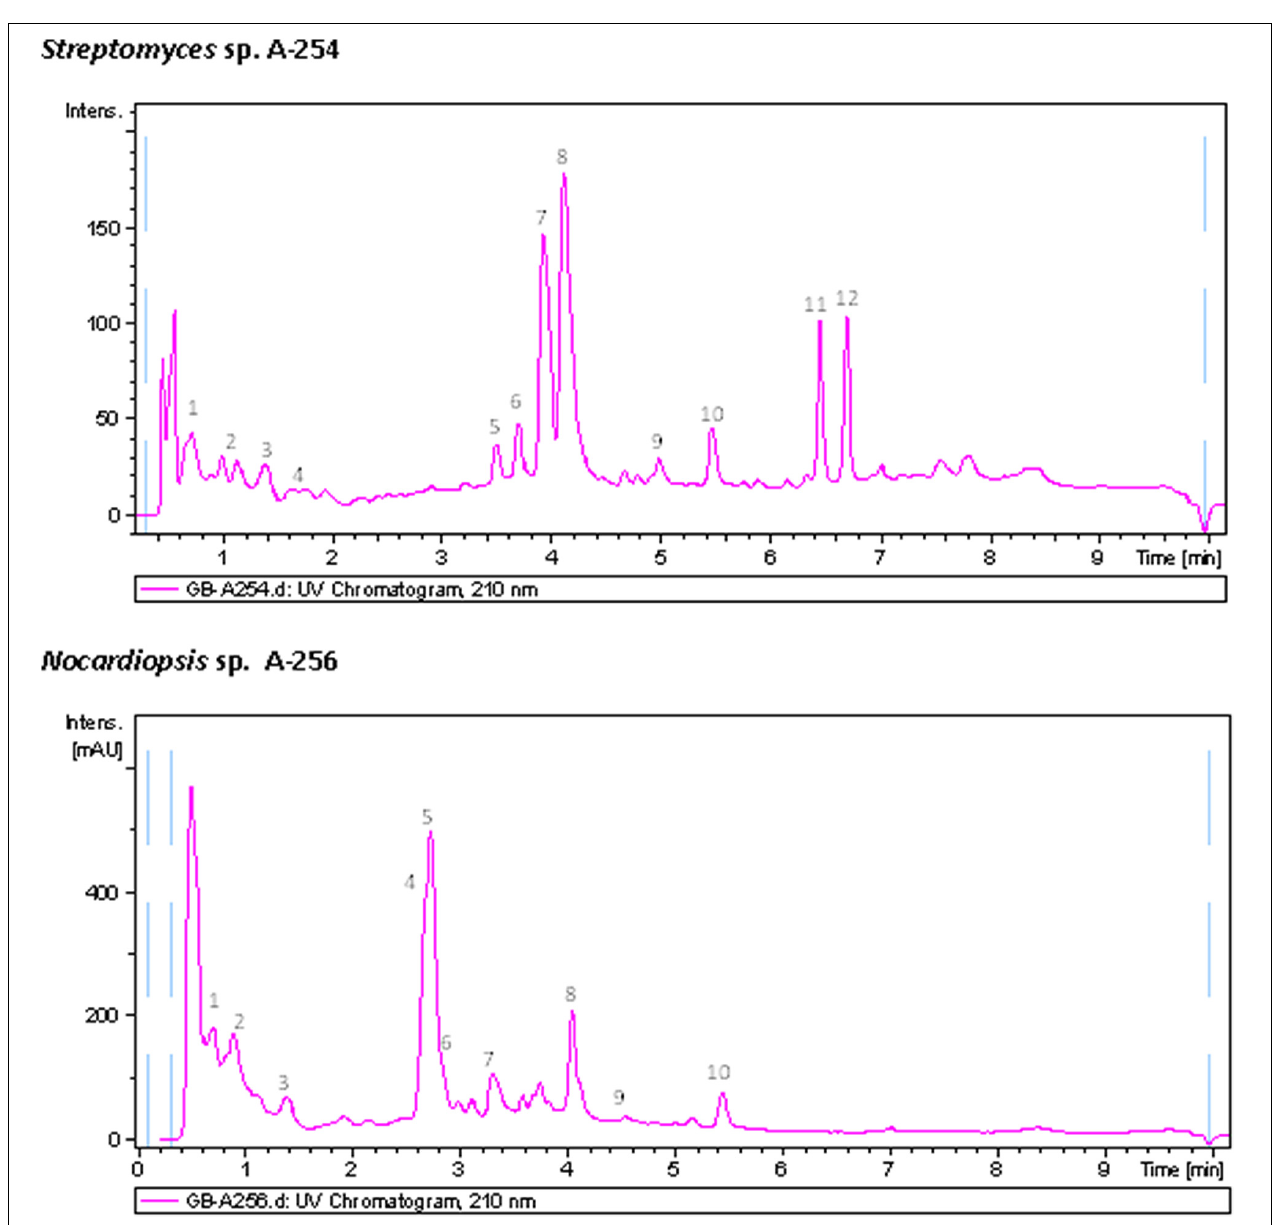
FIGURE 5 | UV 210 nm chromatogram of samples A-254 and A-256 with peaks annotated showing dereplicated components. Dereplicated components in sample A-254: (1) Cyclo(prolylvalyl), (2) Cyclo(leucylprolyl), (3) Cyclo(phenylalanylprolyl), (4) Cyclo(prolytryptophyl), (5) C 21 H 38 NO 9 (related to ravidomycin but with a molecular formula not found in the Dictionary of Natural Products), (6) Deacetylravidomycin, (7) C 30 H 33 NO 9 (related to ravidomycin but with a molecular formula not foundin the Dictionary of Natural Products), (8) Ravidomycin, (9) C 40 H 57 NO 10 (molecular formula not found in the Dictionary of Natural Products), (10) Tetronomycin, (11) Salaceyin A and (12) Salaceyin B. Dereplicated components in sample A-256: (1) Bisucaberin B, (2) Cyclo(leucylprolyl), (3) Kahakamide A, (4) Endophenazine D, (5) Dihydroxyphenazine, (6) 1-Hydroxy-6-methoxyphenazine, (7) 1-Phenazinecarboxylic acid, (8) Piperafizine B, (9)